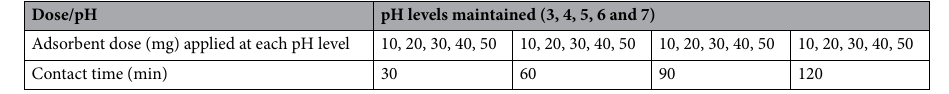
Dose/pH Adsorbent dose (mg) applied at each pH